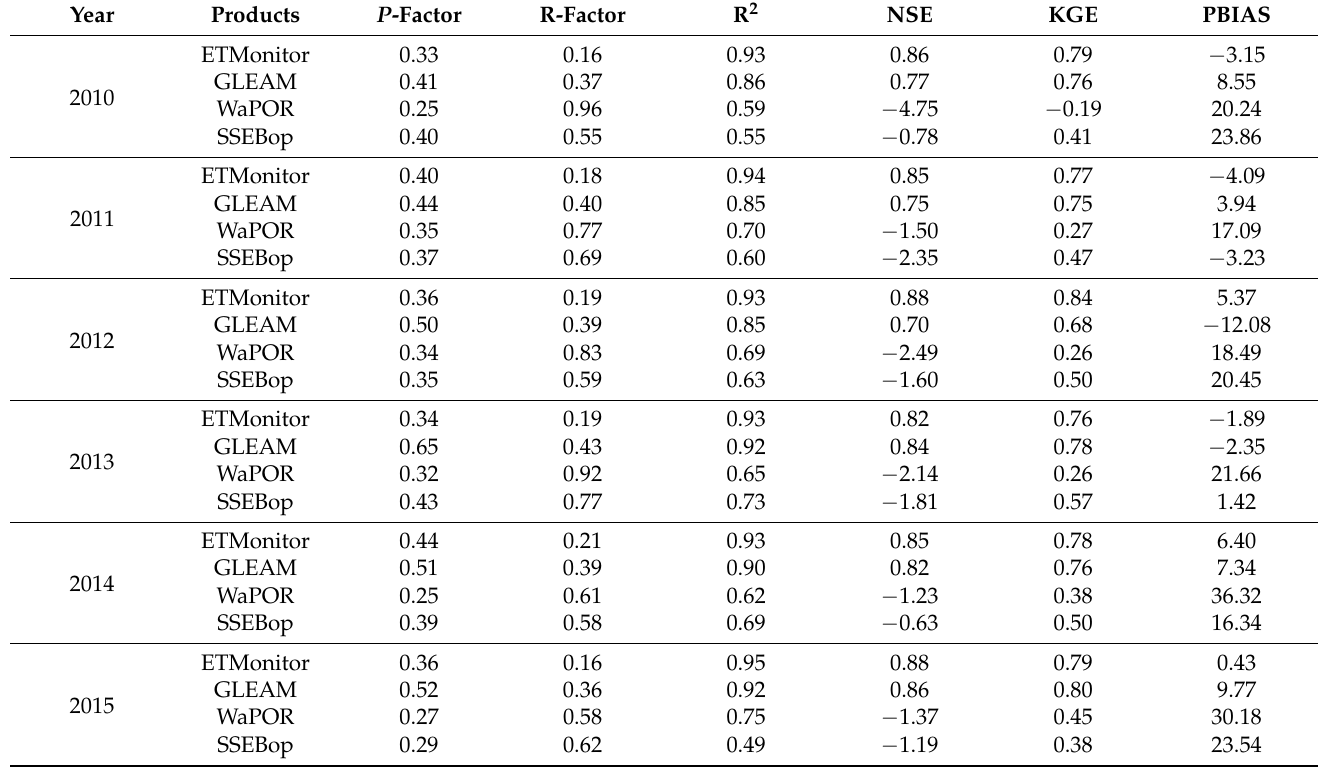
Table 9. Performance metrics of ETa from SWAT_Hargreaves when validated against remote sensing ETa